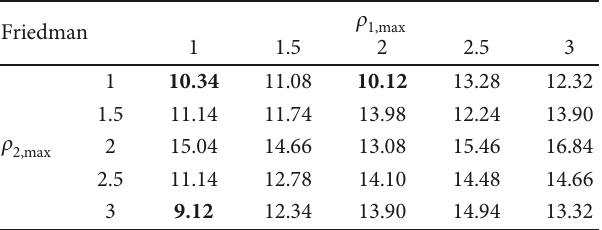
Table 12: Results obtained by the Friedman test for contraction criteria combinations on CEC2005.